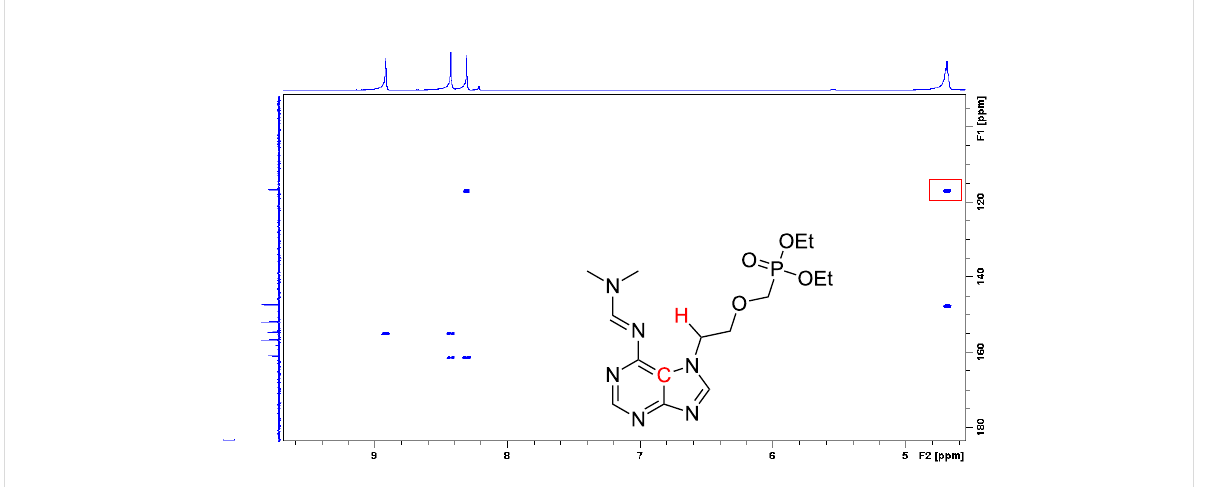
Figure 4: HMBC spectrum confirms N 7-selectivity for the major product 29